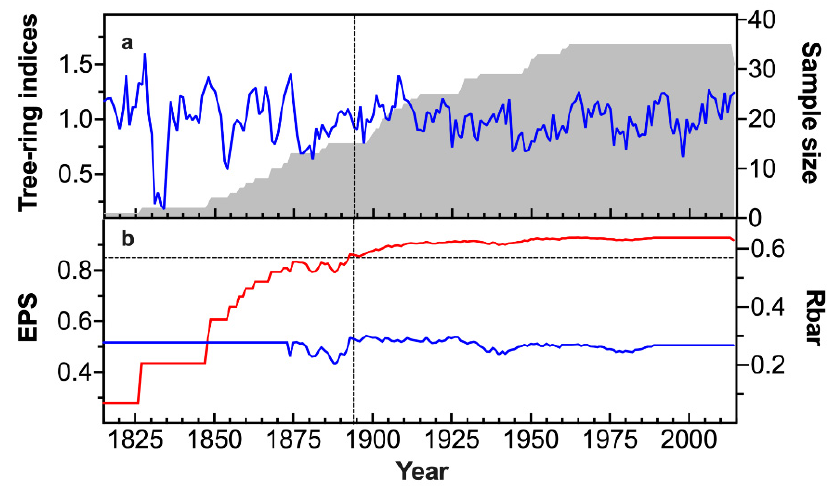
Figure 4. ( a ) TRW chronology at the XHS site in the east Pearl River basin, and the corresponding sample size (gray shading) and ( b ) the running EPS (red) and Rbar (blue) statistics calculated with a 51-year window. Horizontal dashed line in ( b ) denotes the 0.85 cutoff value. Vertical dashed line indicates the beginning of reliable period where the EPS value is above 0.85.